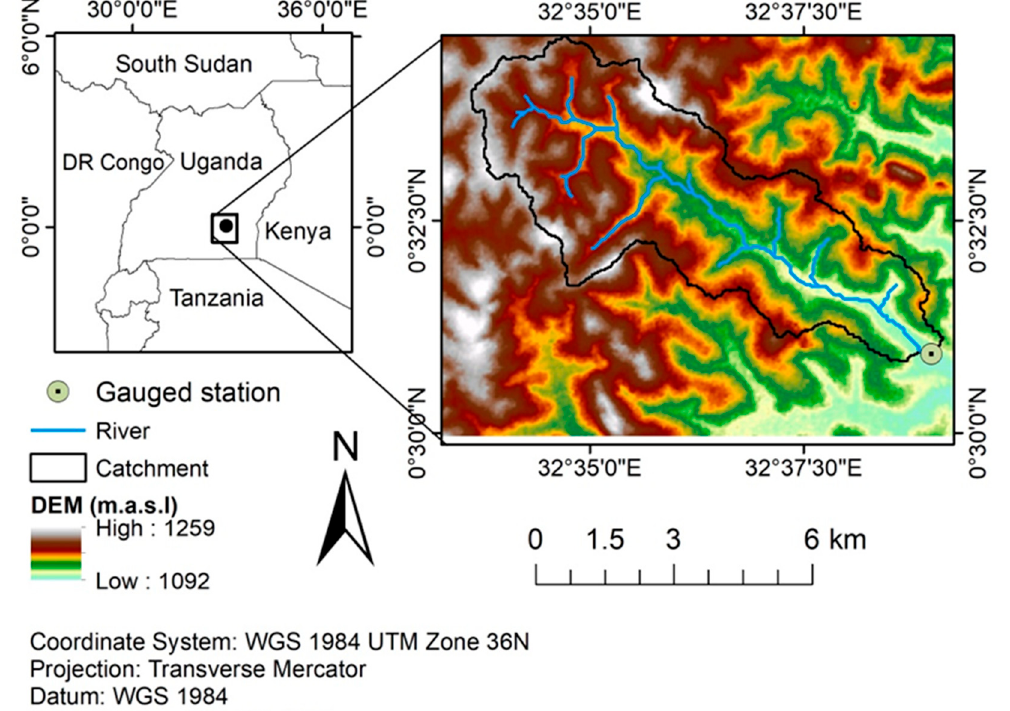
Figure 1. Location of the study area, modified after [31].